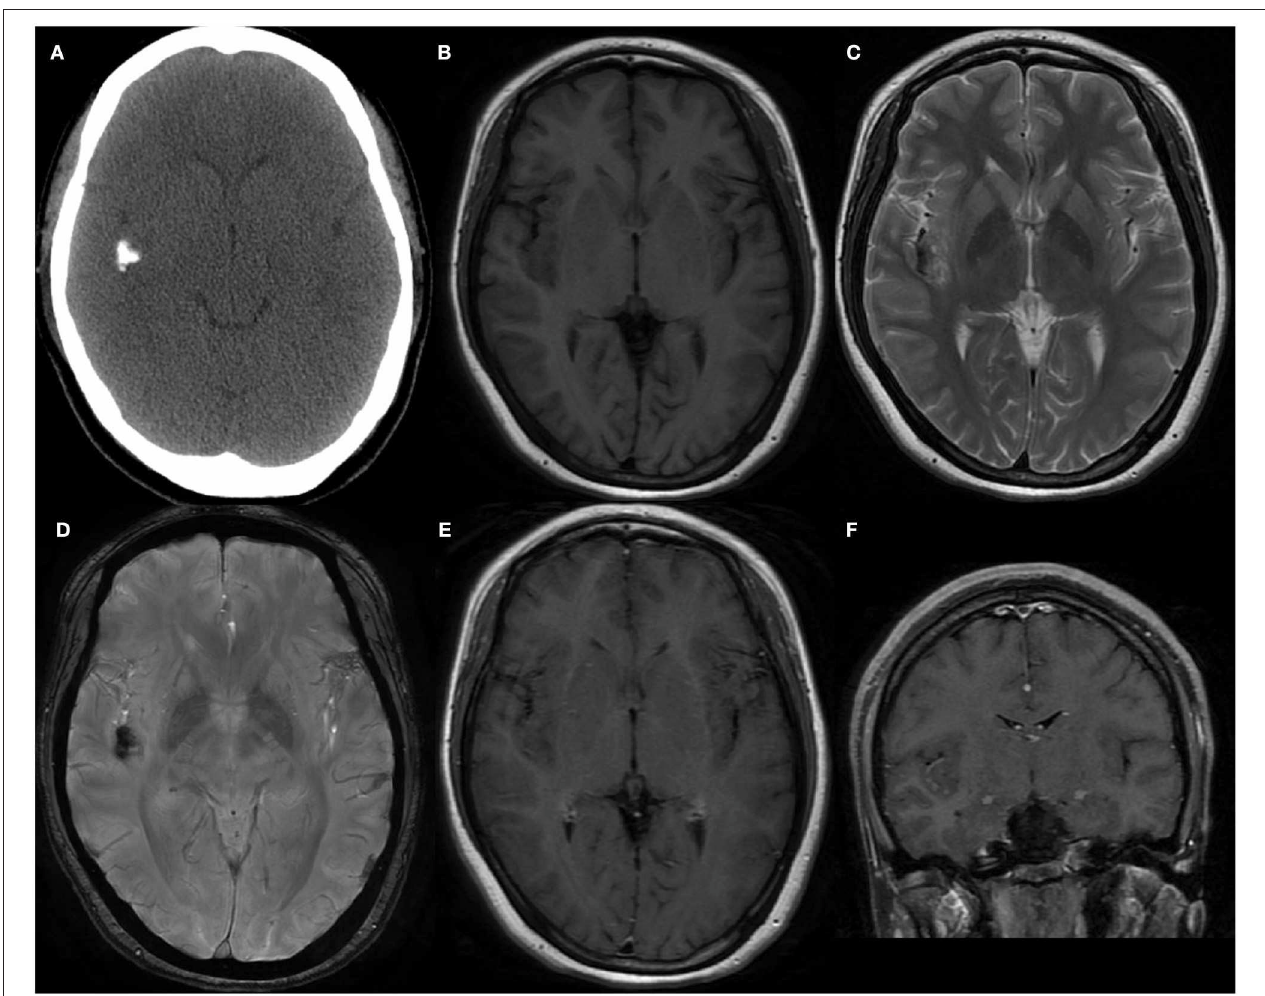
FIGURE 1 | (A) The Computed tomography demonstrated the calcification in right Sylvian fissure and posterior part of insula. (B,C) MRI scans revealed a lesion without dural attachment located in right insular lobe which was mainly hypointense on both T1-weighted and T2-weighted. (D) Lesion showed hypointense on susceptibility weighted imaging. Enhanced MRI showed no obvious enhancement after gadolinium administration in axial (E) and coronal (F)